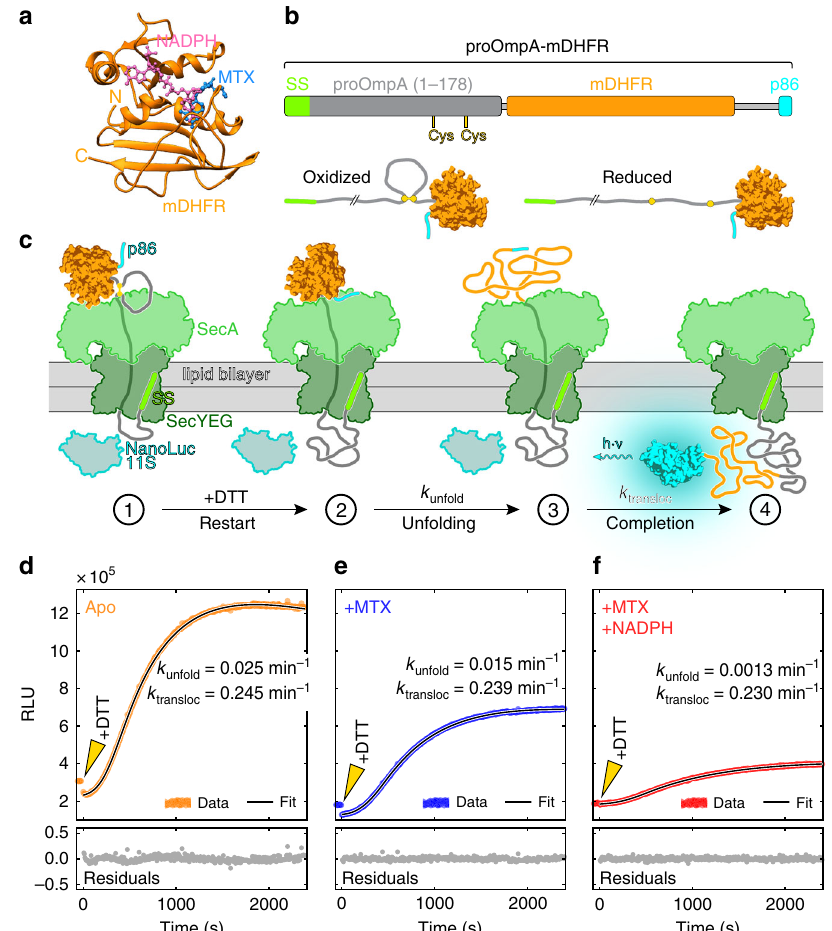
Fig. 1 Synchronized real-time measurements reveal translocation and unfolding kinetics. a Crystal structure of mDHFR bound to the ligands MTX and NADPH (pdb: 1u70). b Schematic of the chimeric proOmpA-mDHFR translocation substrate (top). Two cysteine residues engineered in the proOmpA N- terminal fragment allow the reversible formation of a looped structure (bottom). c Schematic of the translocation experiment. Initial translocation of the oxidized proOmpA-mDHFR substrate results in complexes stalled at the disul fi de loop ( ➀ ). The NanoLuc 11S protein (cyan/gray) is encapsulated inside the proteoliposomes and separated from the complementing p86 peptide (cyan) by the lipid bilayer. Upon DTT addition, translocation proceeds until mDHFR reaches the translocon ( ➁ ). After unfolding ( ➂ ), translocation is completed, resulting in reconstitution of luciferase activity and light emission ( ➃ ). d – f Representative examples of real-time translocation recordings for apo, MTX and MTX + NADPH conditions, showing the recorded data (relative light units, RLU) as colored circles and the fi t to the kinetic model (see main text for details) as a black line. Residuals (bottom) indicate that the fi t describes the data well. Addition of DTT at t = 0 (arrowheads) restarts translocation. Ligands decelerate unfolding of mDHFR ( k unfold ), resulting in reduced rates and amplitudes of the translocation signal. The translocation rates ( k transloc ) are similar for all conditions. Source data are provided as a Source Data fi le.